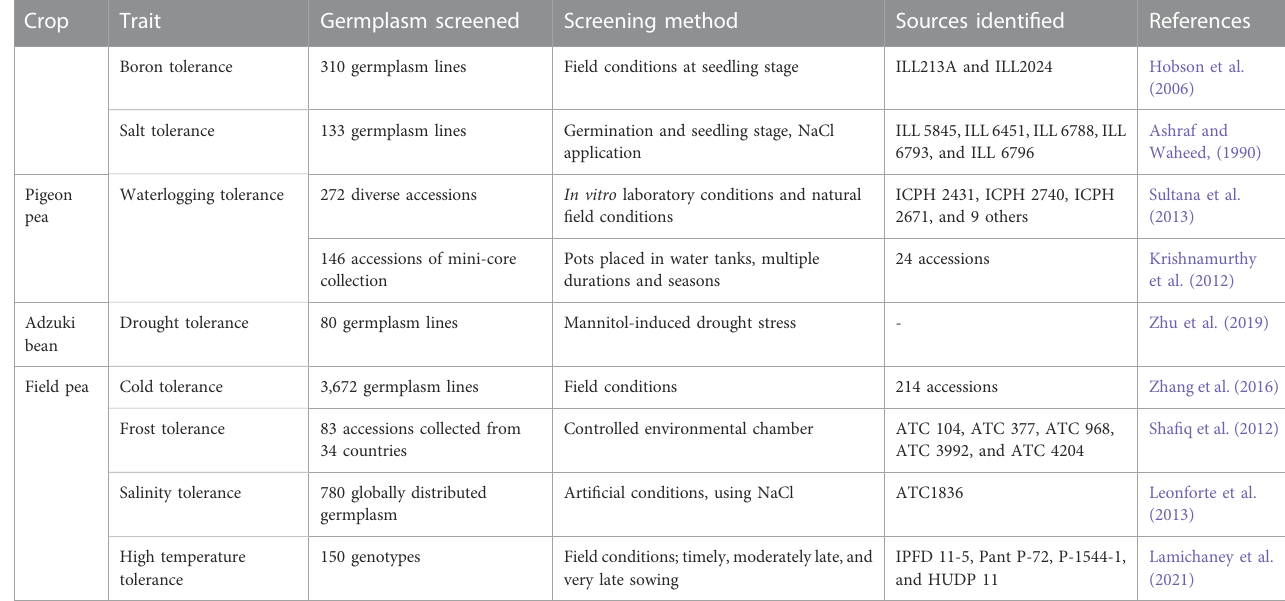
#FIGS: focused identi fi cation of ermplasm